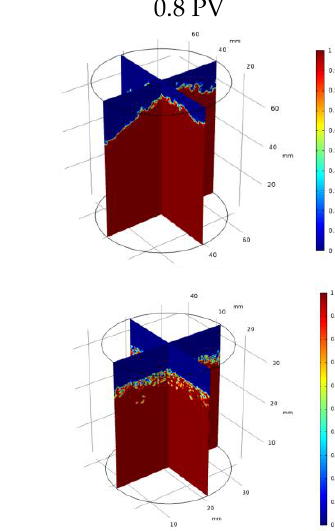
stable displacement front. The injected gas can flow faster toward the outlet due to the